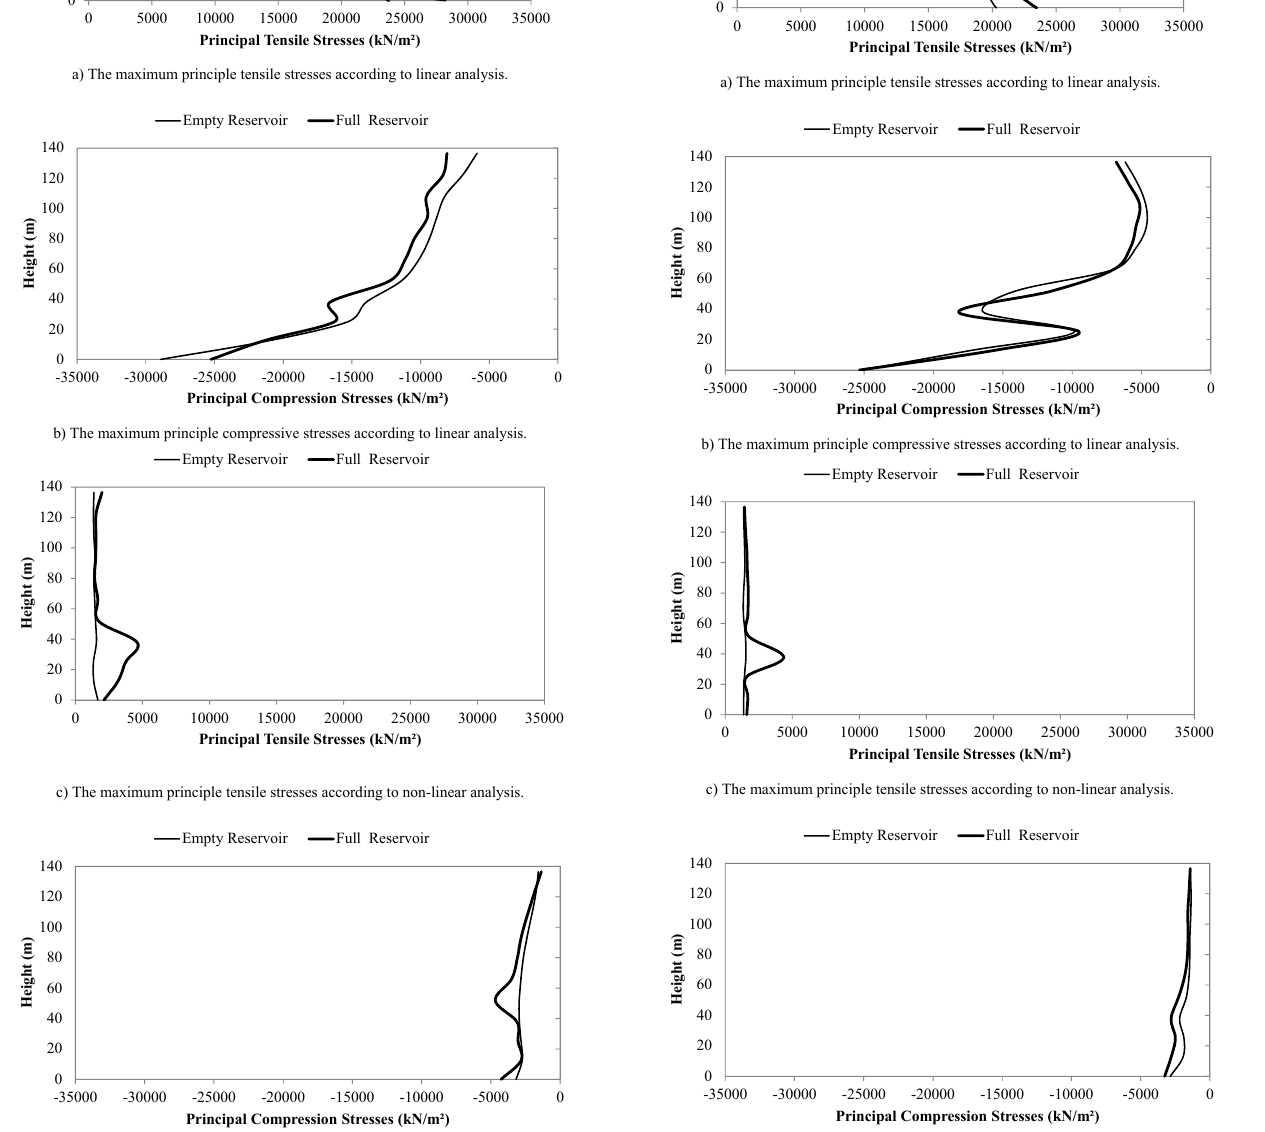
Fig. 19. The maximum principle stress components in I-I section.